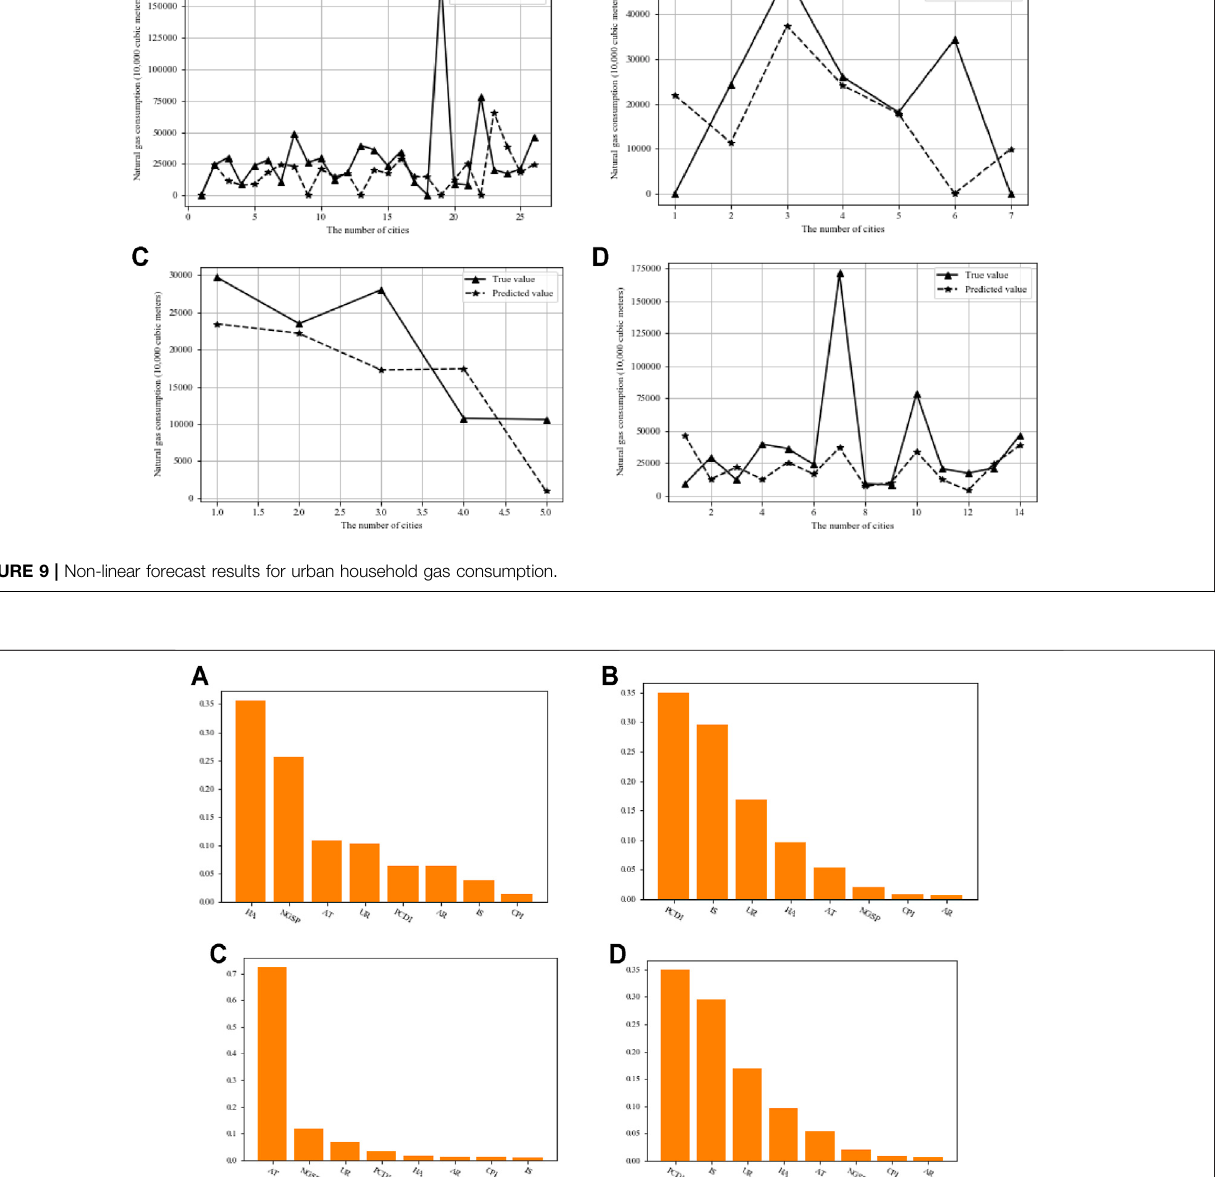
FIGURE 10 | Importance of non-linear predictor variables for urban household gas